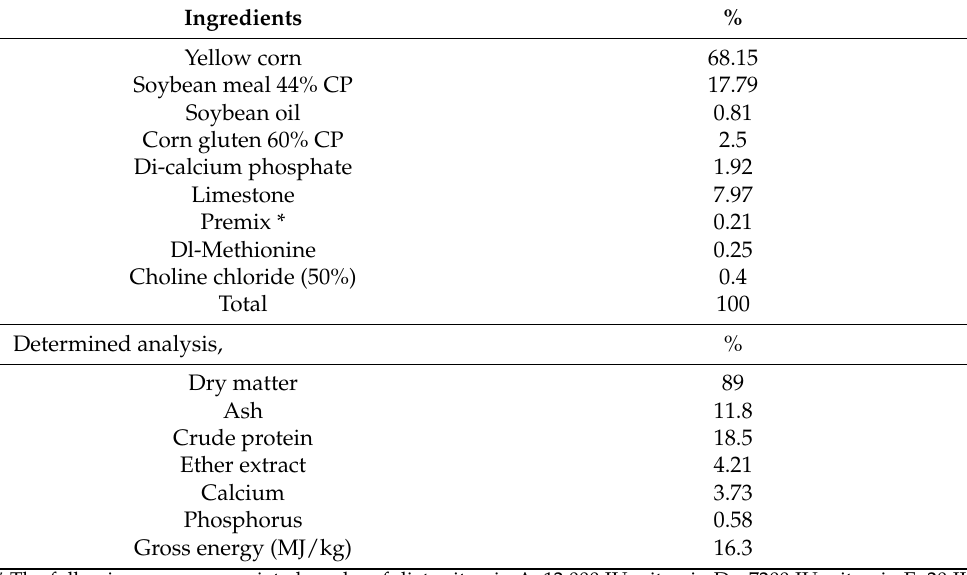
Table 1. Ingredient composition and chemical analysis of the basal diet (in